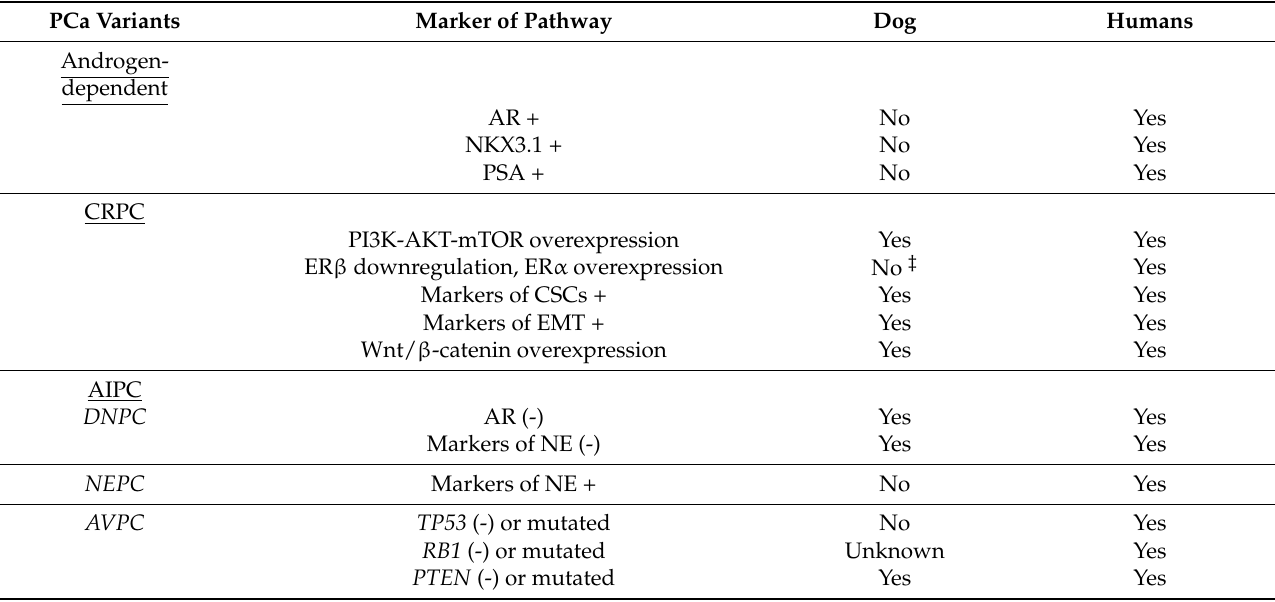
Table 1. Summary of molecular characteristics of dog and human